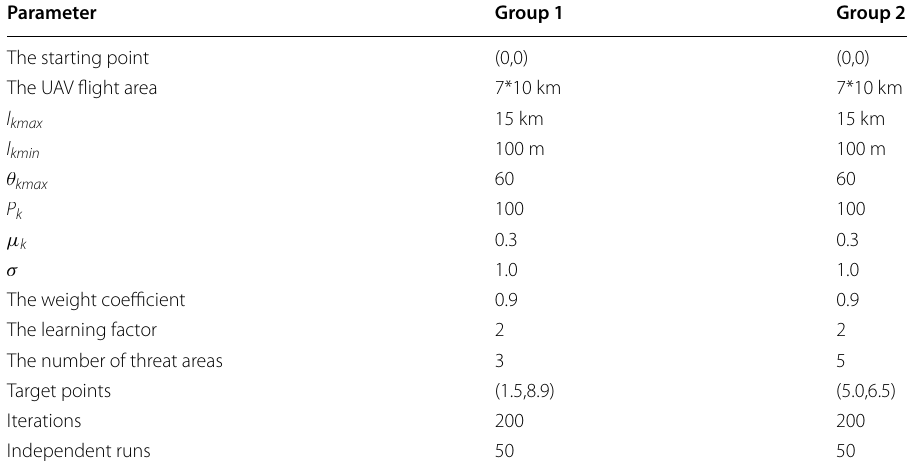
Table 6 The parameter settings of route planning